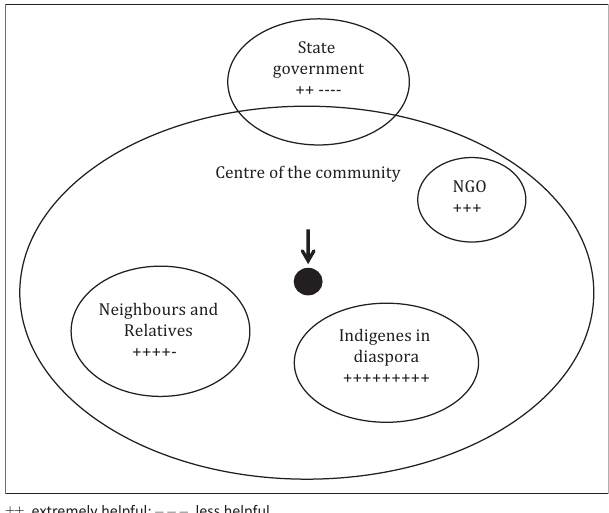
FIGURE 2: Venn diagram showing important institutions that enabled farmers bounce back into food production in the aftermath of the 2012 flood